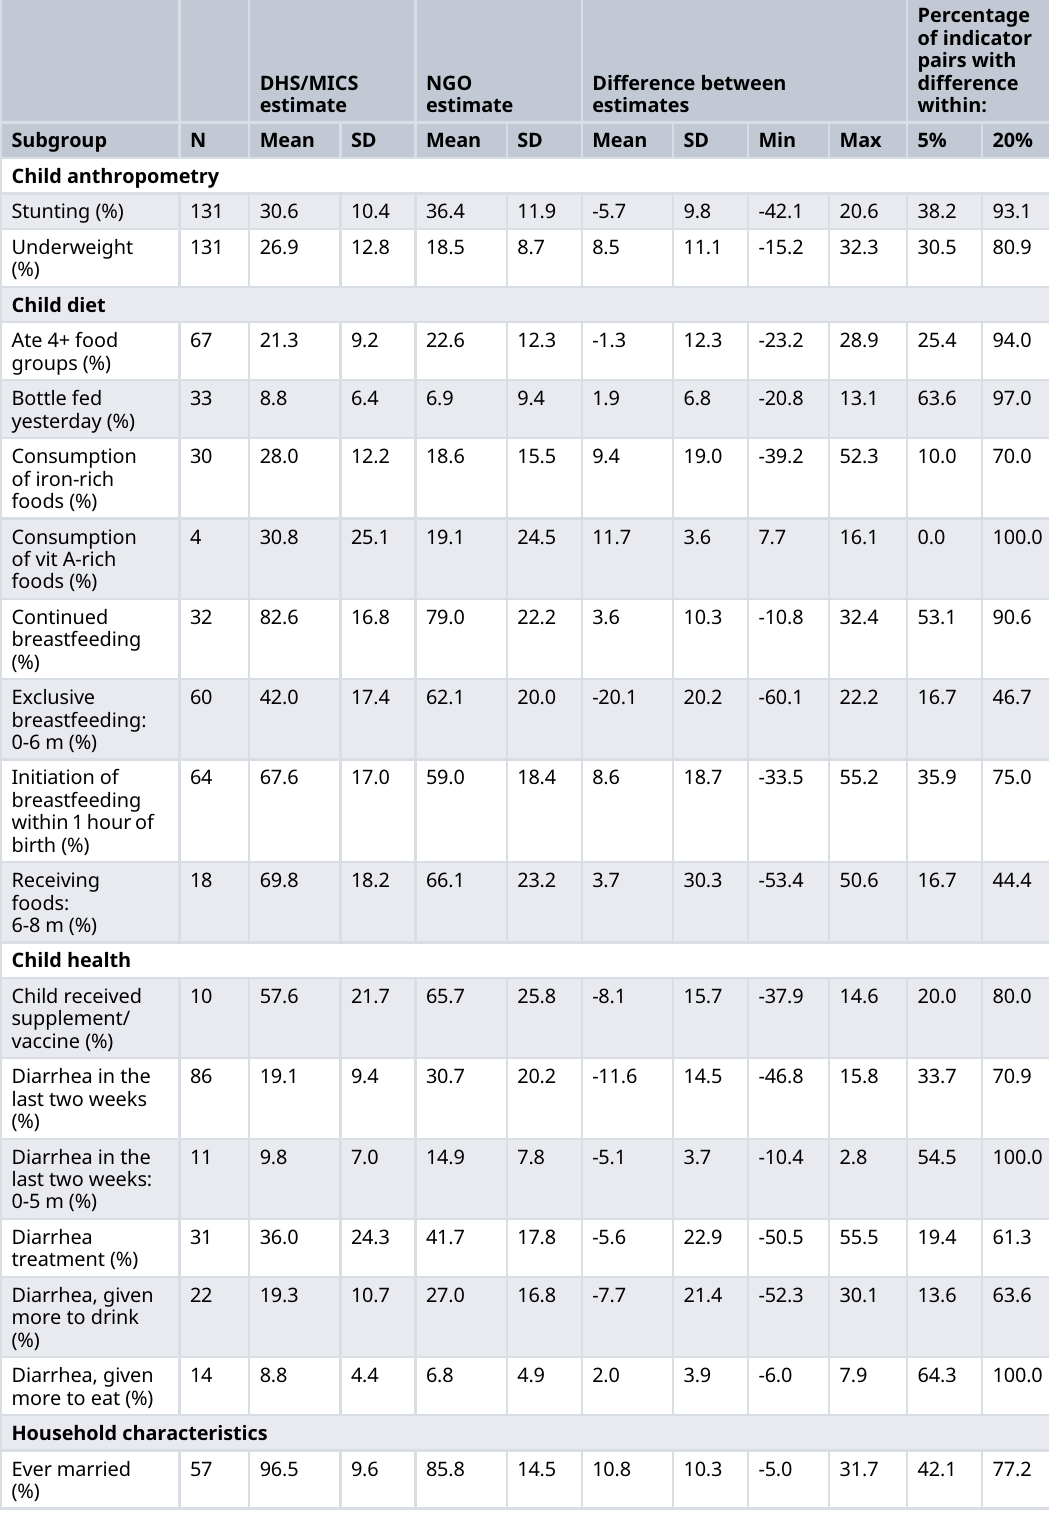
DHS/MICS NGO Difference between estimate estimate estimates